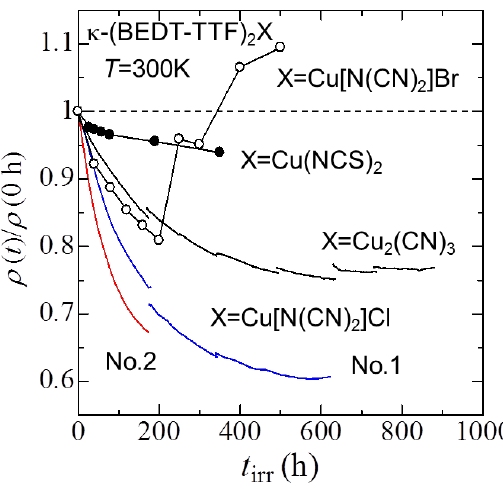
Figure 3. X-ray irradiation time dependence of the in-plane resistivity of κ-(BEDT-TTF) at 300 K [20]. Each resistivity curve is normalized by the value before the